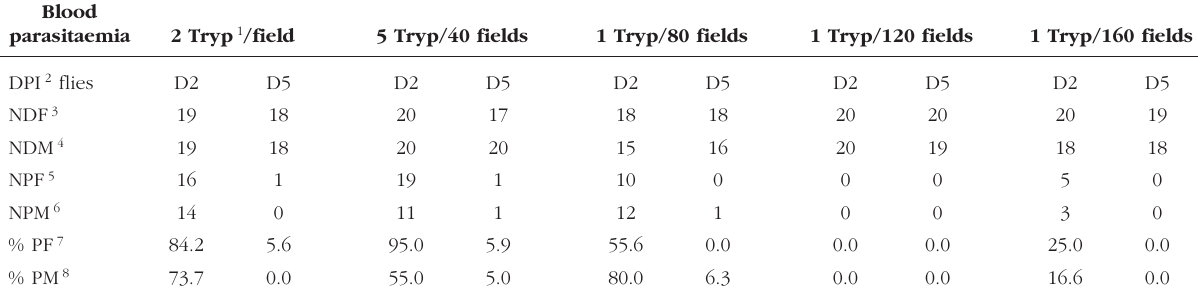
Table I. – Results of xenodiagnosis with G. m. submorsitans fed on cows infected with T. congolense at different parasitaemia.